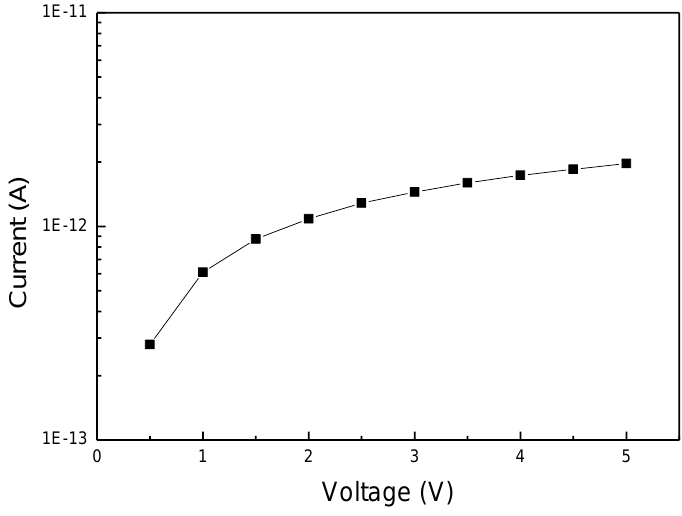
Figure 9. IV curve of the sensor device after GO filling.